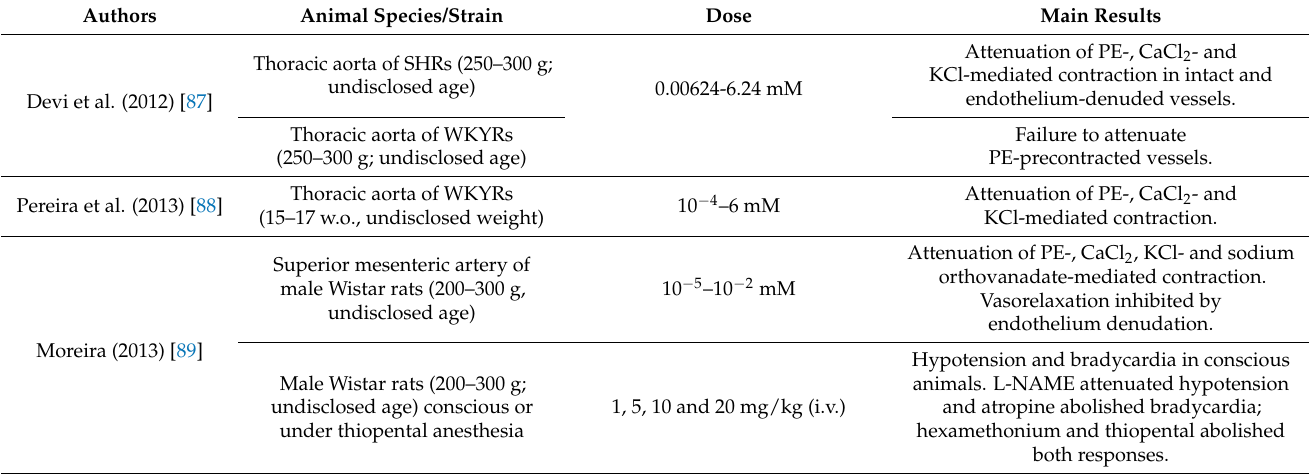
Table 3. Results of the vasorelaxant activity of citral in ex vivo and in vivo studies (WKYRs–Wistar- Kyoto rats; SHRs–spontaneously hypertensive